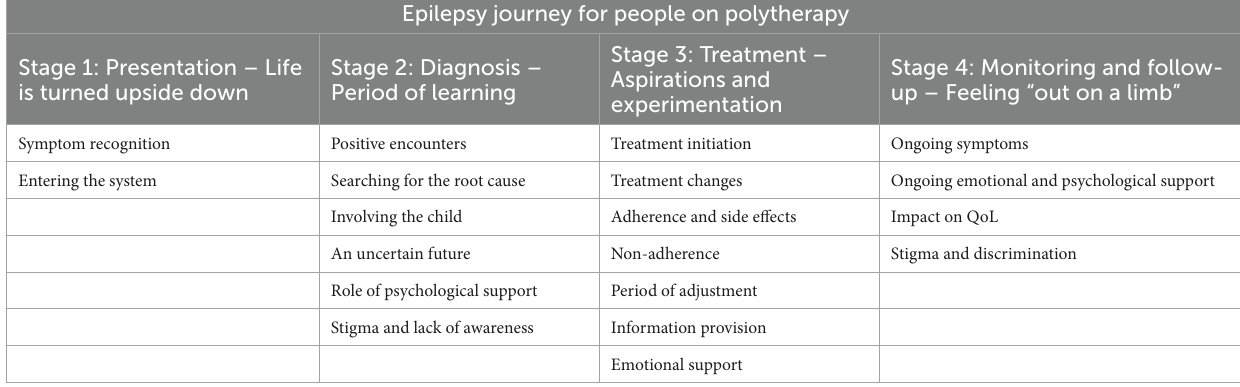
TABLE 3 Themes and sub-themes within each of the four clinical stages of the epilepsy journey. Epilepsy journey for people on